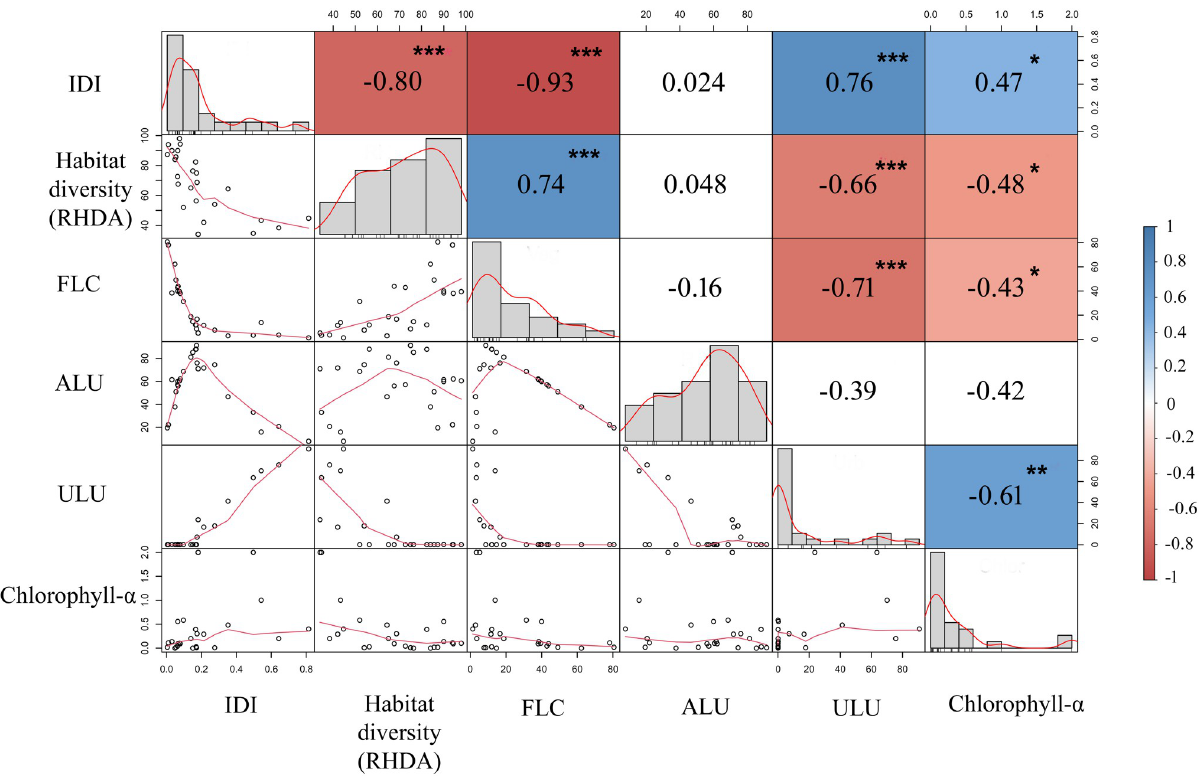
Fig 2. Spearman correlations among percentage of land use (%) (FLC—Forest Land Cover; ALU—agricultural land use; ULU—urban land use), Habitat diversity, Integrated Disturbance Index- IDI, and productivity (chlorophyll- α biomass) from the 25 streams sampled in the Iguac¸u, Piquiri, and Ivaı´River Basins, Brazil. The values in the squares represent the correlations, asterisks indicate significant correlations, blank squares indicate no significant correlations.